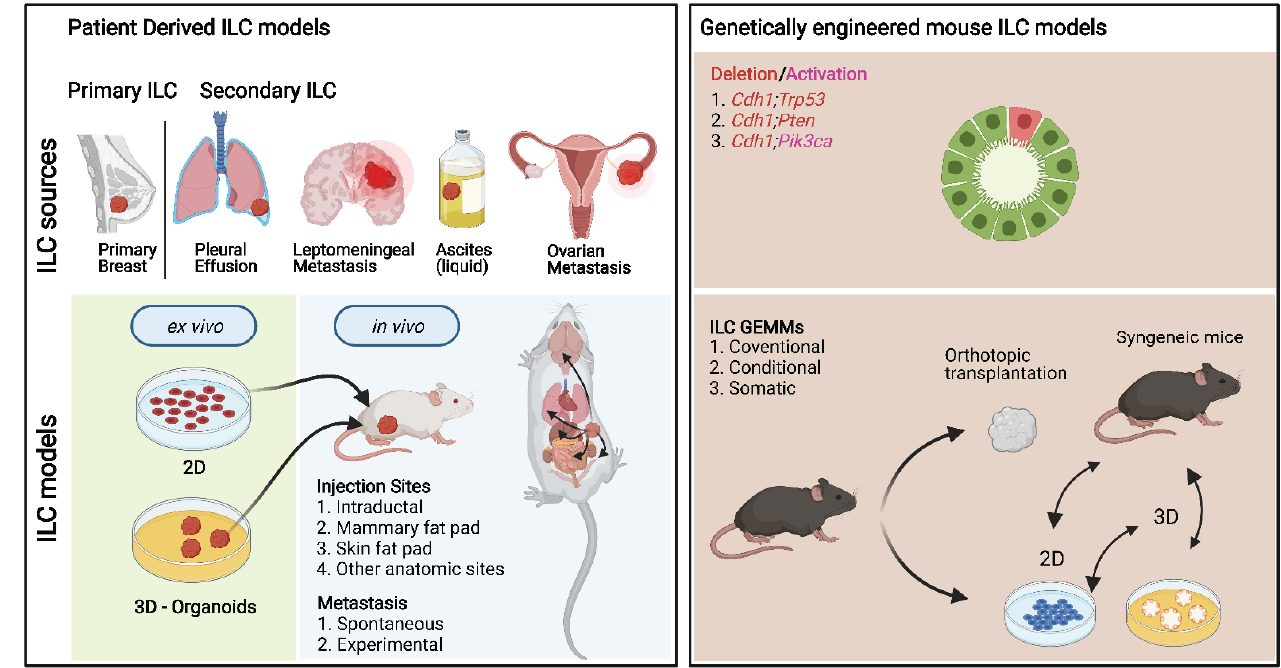
Figure 3. Schematic overview of different key ILC models. Left: Patient-derived ILC models. Primary and secondary ILC tissues are commonly used to establish ILC lines, organoids, xenografts, and PDXs. Right: Genetically engineered mouse ILC models (GEMMs). To study the direct consequence of genetic inactivation of E-cadherin, encoded by the Cdh1 gene, and other frequently mutated genes in invasive lobular carcinoma (ILC) of the breast, various GEMMs have been developed.